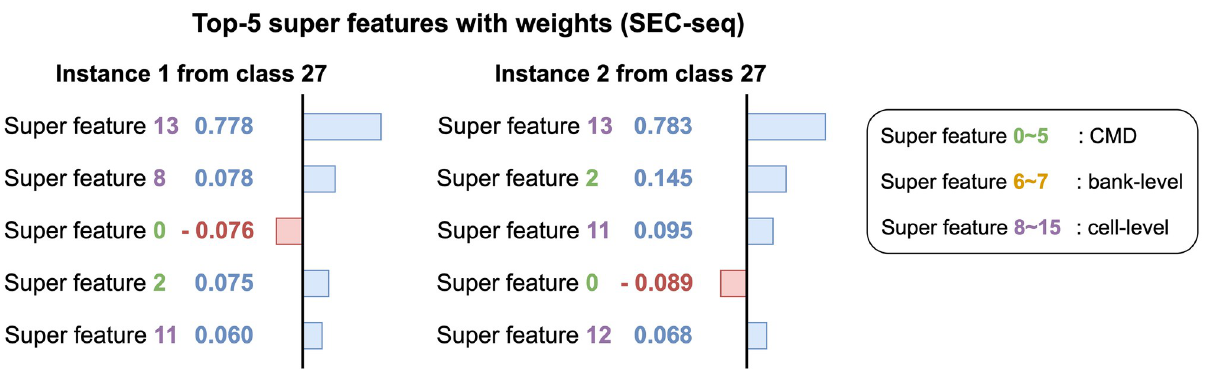
Fig 1. Interpretation of two instances for class 27 from the SEC-seq dataset. Both instances are correctly classified as class 27. Three types of super features are denoted as green, yellow, and purple colors, respectively. Note that cell-level super features, especially the super feature 13, influence the predictions the most while super feature 0 commonly gives a negative impact. In other words, INFO accurately predicts labels of input instances as the class 27 since the instances have a unique pattern of accessing a specific memory region related to super feature 13.